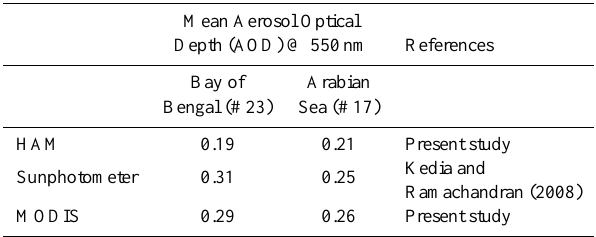
Table 1. Comparison between the ship-based remote sensing mea- surements, MODIS observations and model-simulated mean AODs over the Bay of Bengal and Arabian Sea legs during ICARB cruise